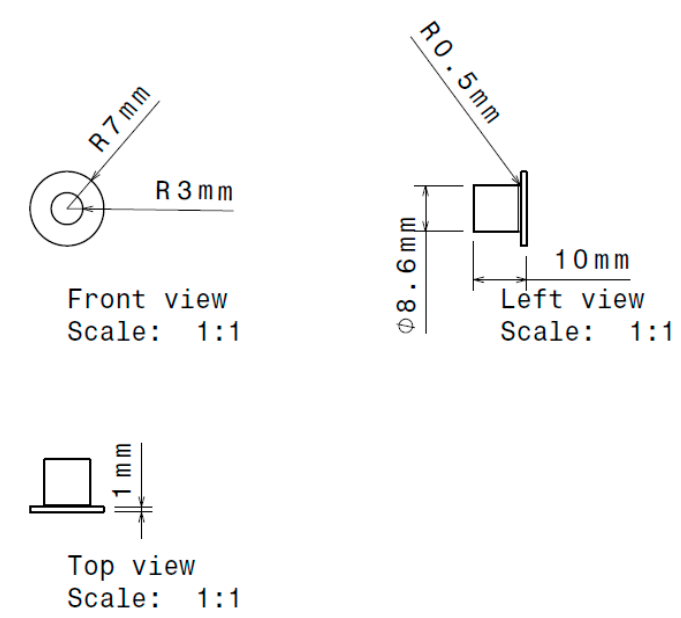
Figure 7. The dimensions of the bush part.